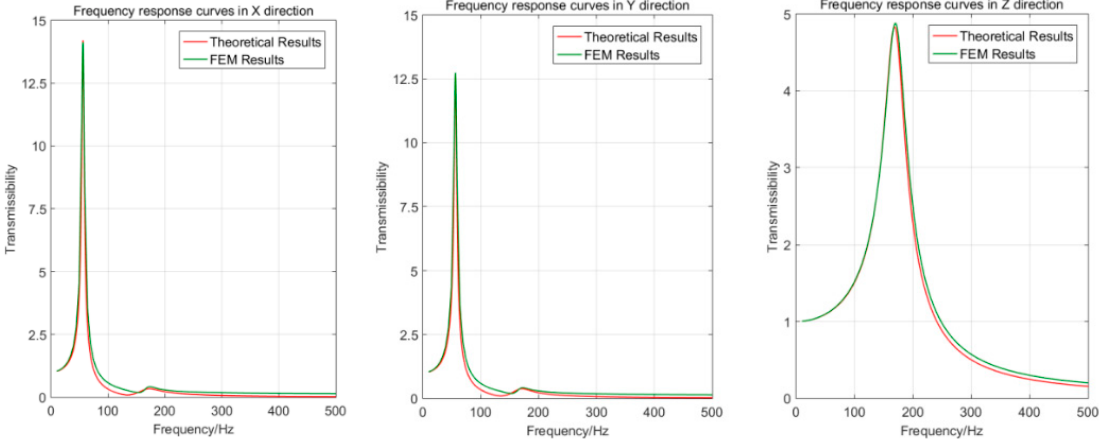
Figure 11. Frequency response curves obtained from FEM simulation and theoretical calculation.